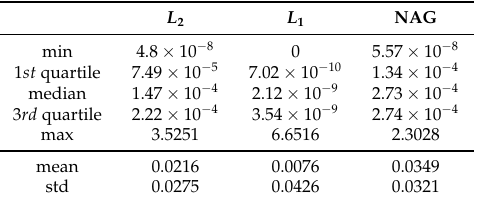
Figure 9. Comparison of baseline’s weights with weights obtained by models that use weight decay regularization methods with regularization parameter λ = 5 × 10 − 5 . Table 6. Summary statistics of absolute values of